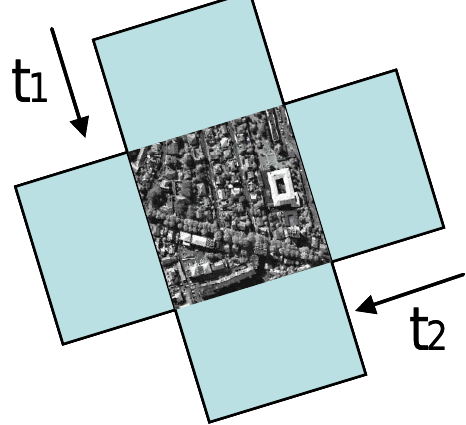
Figure 6: cross-track acquisitions of a same landscape